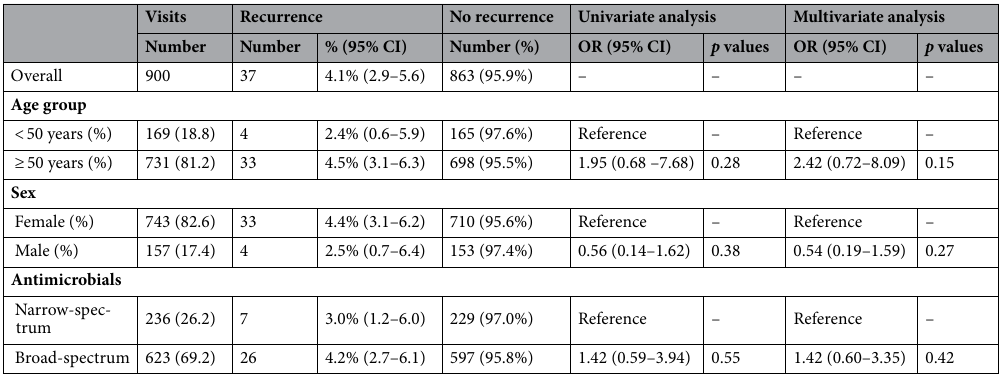
Table 5. Univariate and multivariate analysis for recurrence of cystitis. OR odds ratio. Of the total 902 cases, 2 cases were excluded from the analysis since they were lack of information on the recurrence. Consequently, 900 cases were subjected to the univariate analysis (Chi-square test) and multivariate analysis (logistic regression